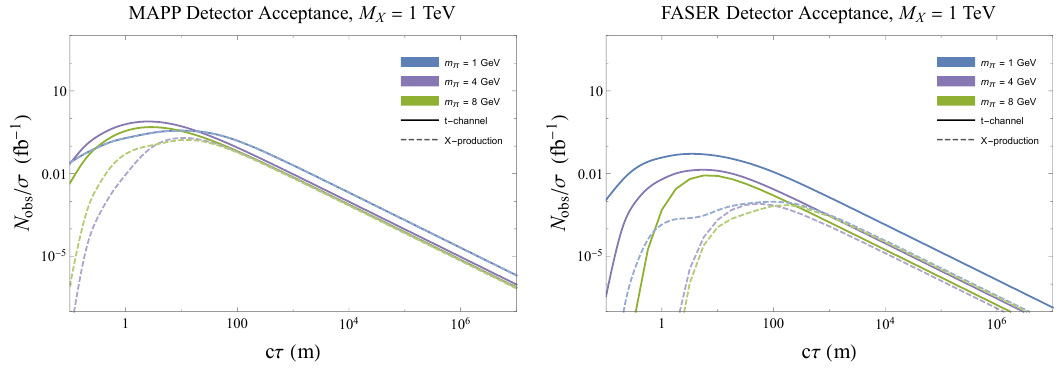
Figure 6 . Expected observed dark pions per cross section for MAPP (left) and FASER (right) as a function of dark pion lifetime. Coloured lines distinguish between different pion mass benchmarks. Dashed lines represent the X d -production explained in section 4. Solid lines represent the t -channel exchange of X d